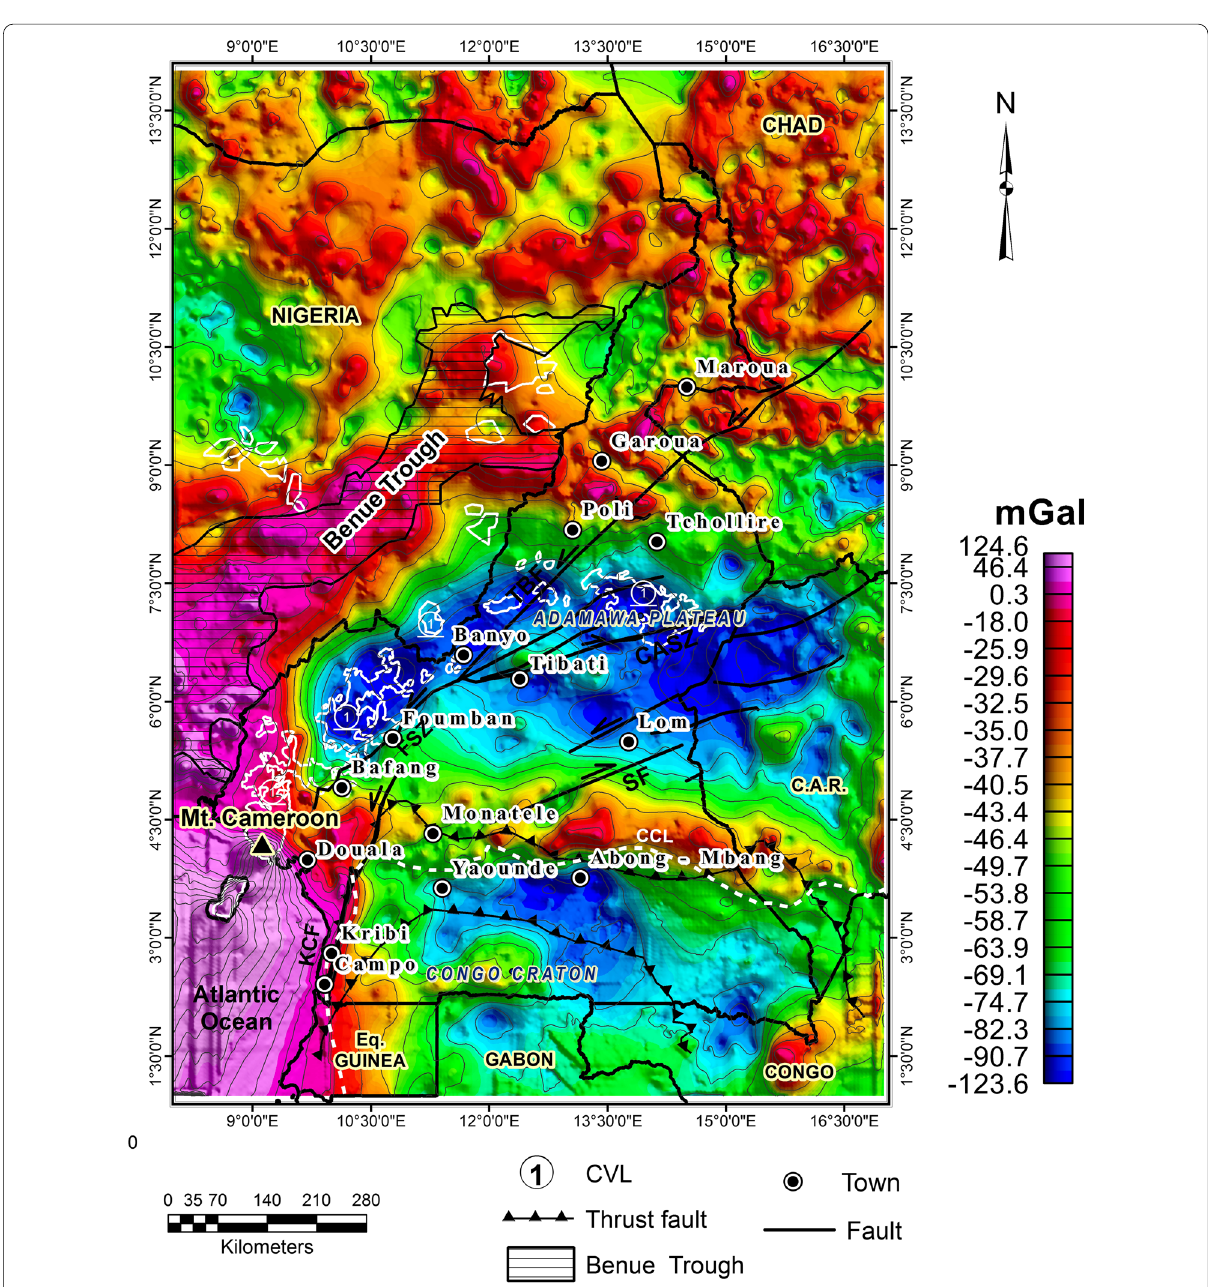
Fig. 3 Bouguer anomaly map of the study area interpolated using data from Fig.